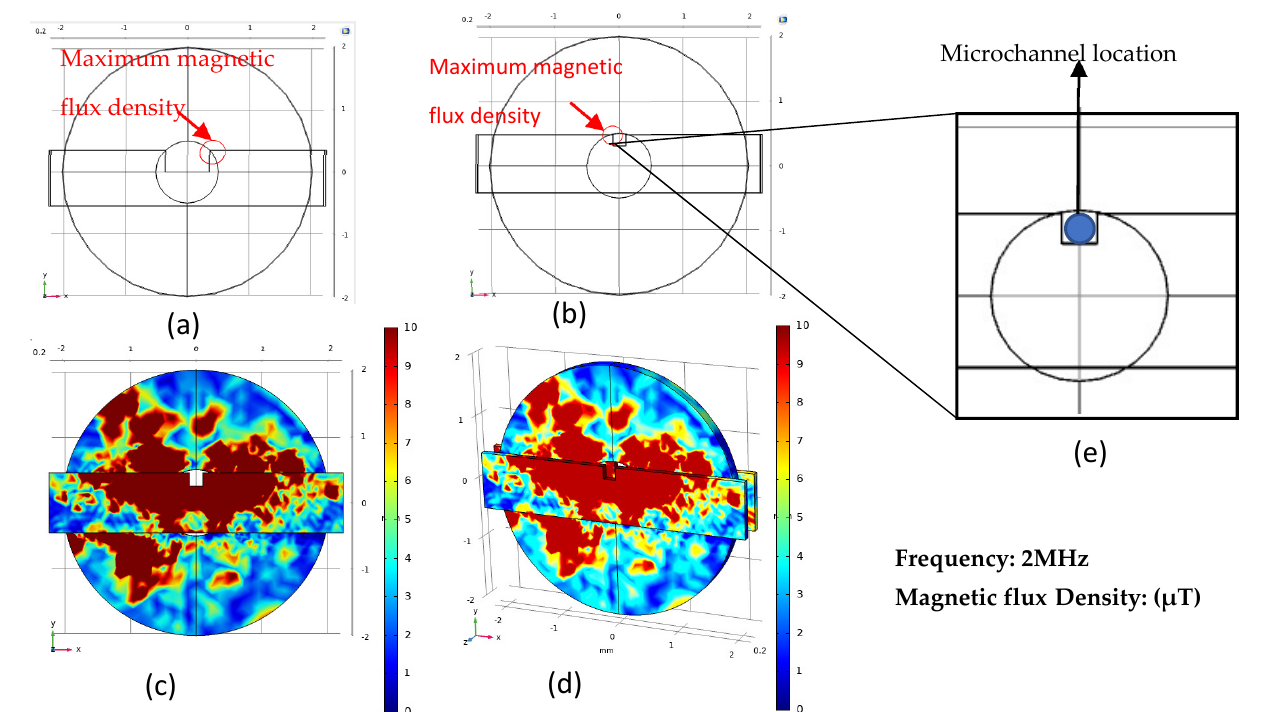
Figure 6. Permalloy structure with the highest magnetic flux density: ( a ) 1200 μ m wide rectangular slot, the maximum magnetic flux density is at the edge of the slot and inner hole of the coil; ( b ) A rectangular slot with a width of 300 μ m and a depth of 500 μ m, the maximum magnetic flux density is at the edge of the slot and inner hole of the coil; ( c ) Simulation results corresponding to the figure ( b ); ( d ) The result of two pieces of Permalloy in figure ( b ); ( e ) The Microchannel location in figure ( b ).